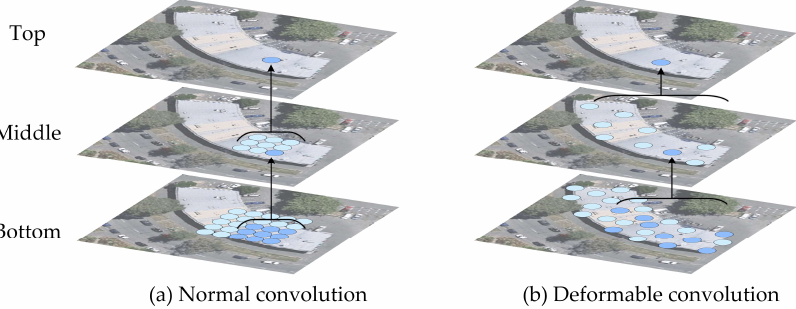
Figure 5. Schematic diagrams of ( a ) a normal convolution and ( b ) a deformable convolution. From the bottom to the top, the sampling points are fixed in the normal convolution, while the sampling points in the deformable convolution adjust according to the shape of the object.